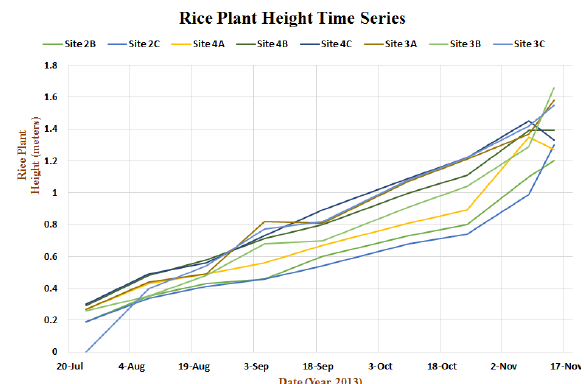
Figure 6: Rice Plant Time Series